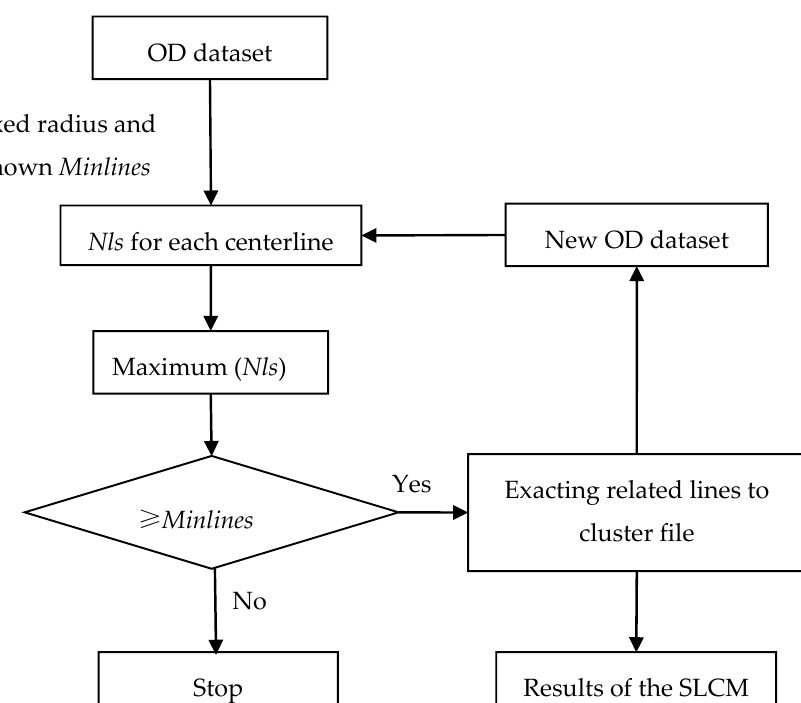
Figure 6. The overall process of the SLCM with fixed radius.